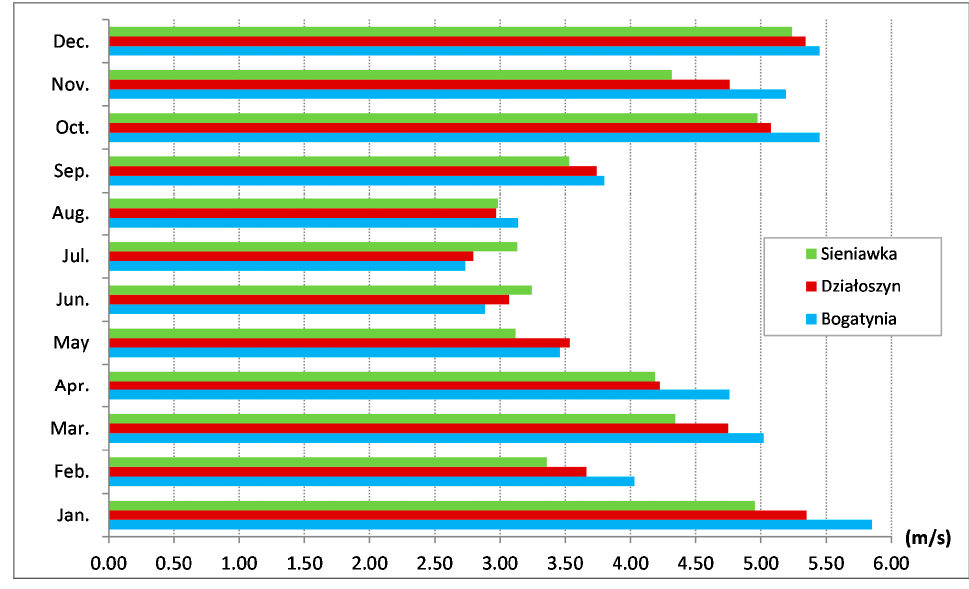
( c ) Figure 8. The distribution of wind directions and wind speeds determined by the WRF/CALMET model in the meshes of the meteorological grid corresponding to the location of selected towns in 2018 (Source : Own study): ( a ) Bogatynia, ( b ) Sieniawka, ( c ) Dzia ł oszyn.